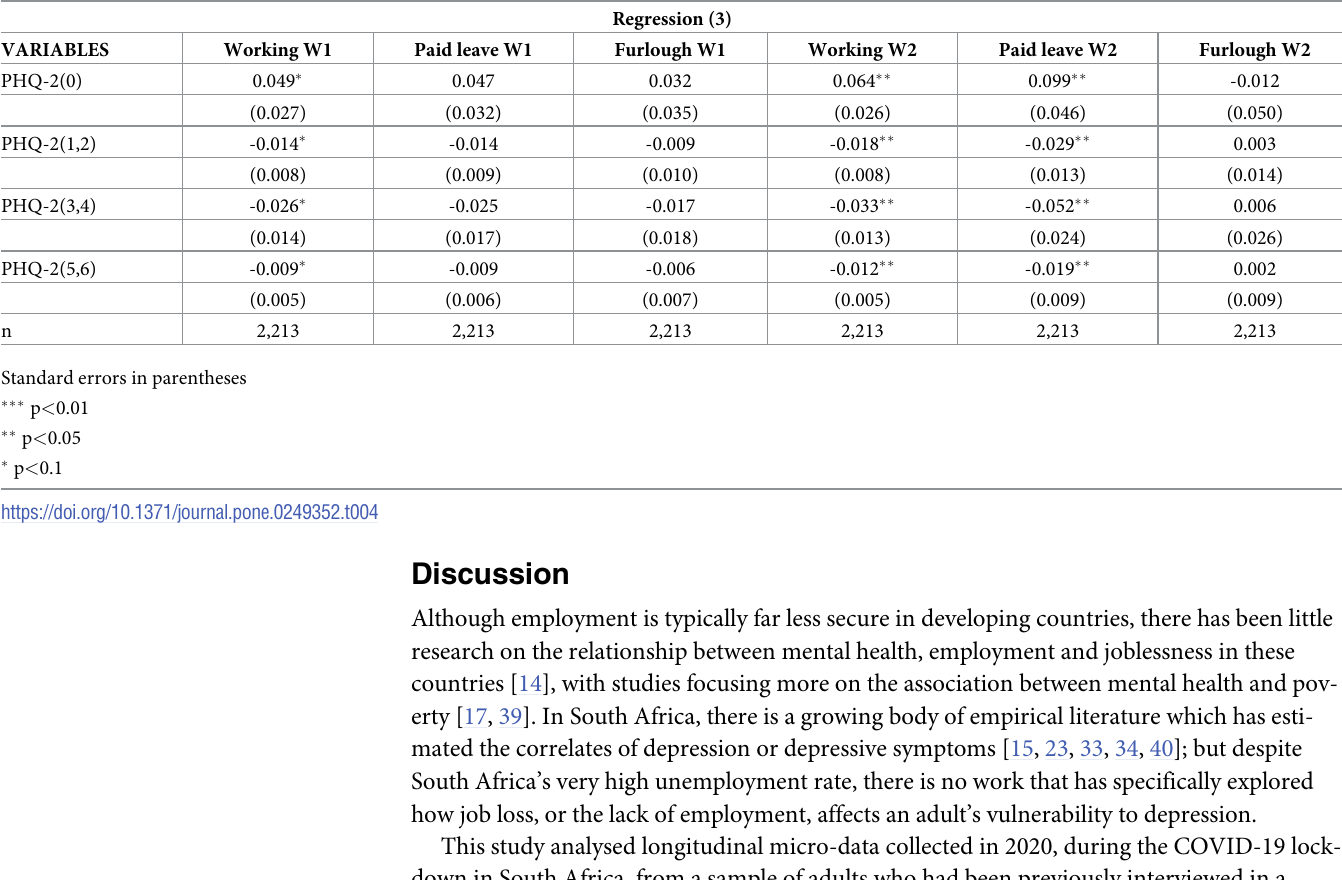
Table 4. Marginal effects (Regression 3).